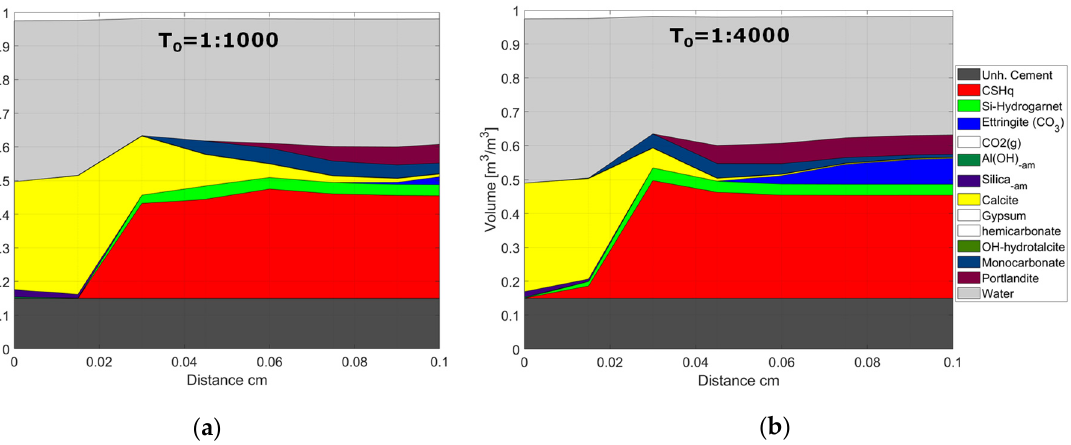
Figure 12. Phase assemblage after 1400 h of exposure. Modeled results are shown for two values of the initial tortuosity factor (T 0 ): ( a ) T 0 = 1:1000 and ( b ) T 0 = 1:4000. The unhydrated cement represents the amount of unreacted cement at the time of hydration. The white blocks in the phase assembly legend indicate phases included in the chemical model, but not present at the displayed time.